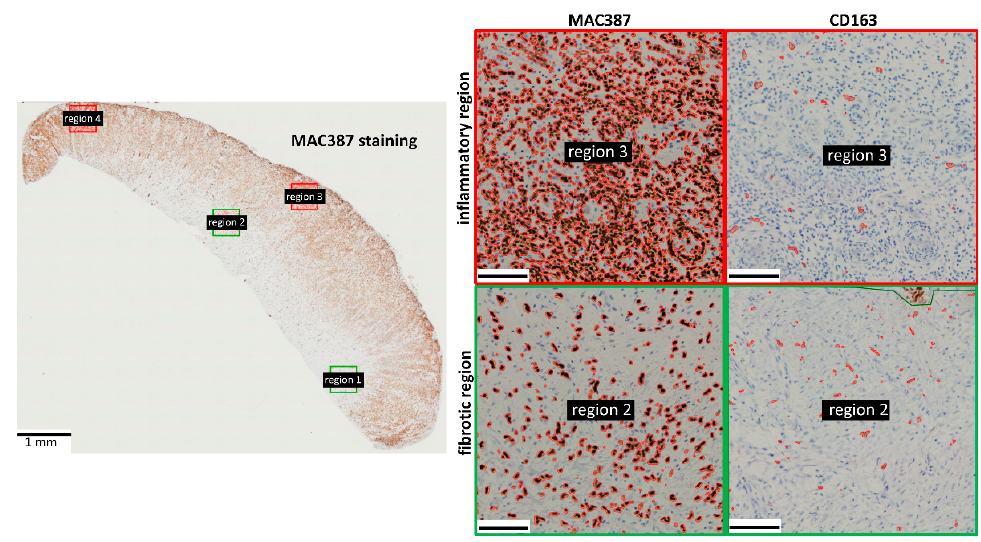
Figure 3. Immunohistochemistry showing the spatial organization of MAC387+ cells and CD163+ cells in horse EGT. The majority of the MAC387 staining was found in the inflammatory regions (indicated in red) near the wound surface. The CD163 staining was more uniformly distributed. Stained pixels were detected using the positive pixel count algorithm in QuPath and encircled in red. Scale bar inserts = 100 µm. Red frame: inflammatory regions; green frame: fibrotic regions.